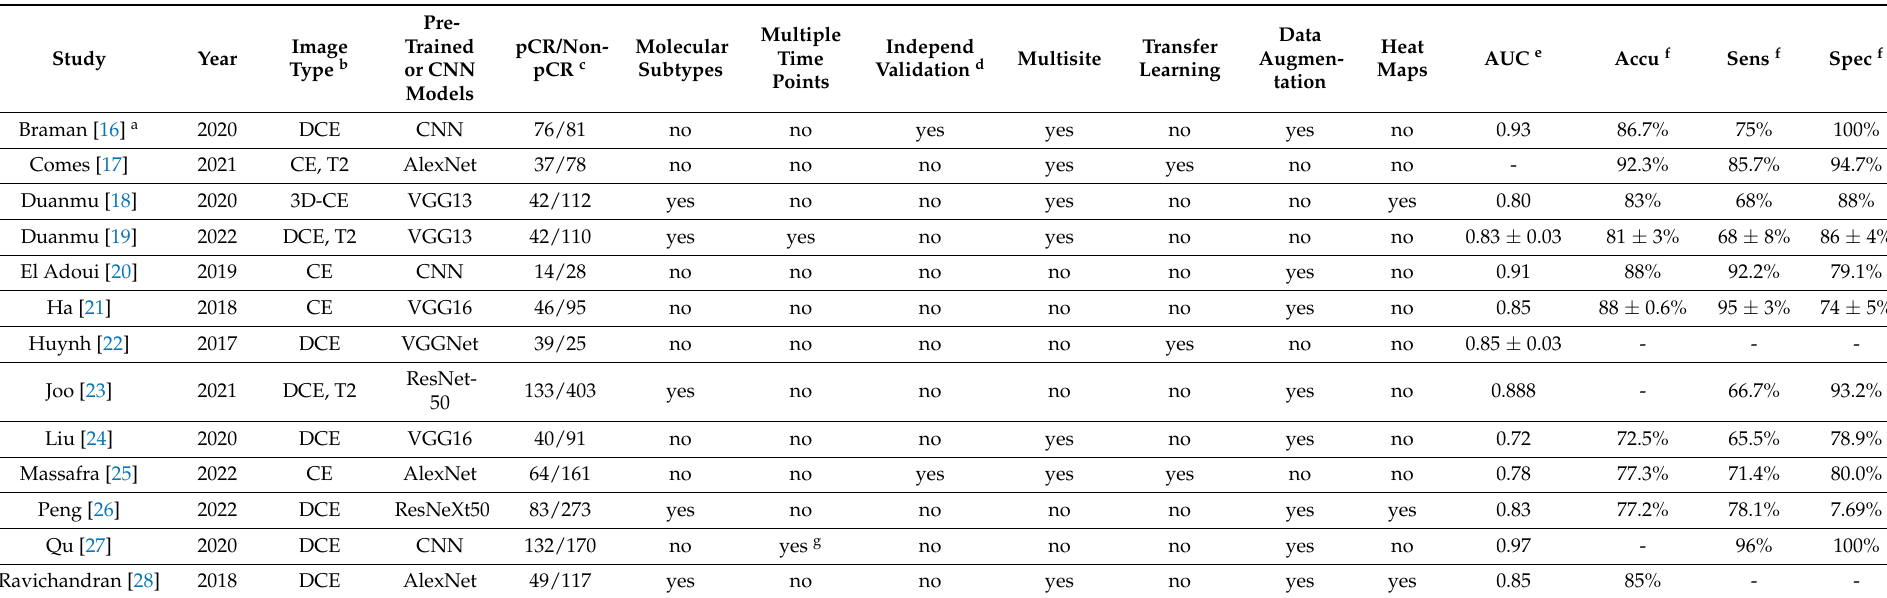
Table 1. Summary of papers on deep learning prediction of pathological complete response in breast cancer using